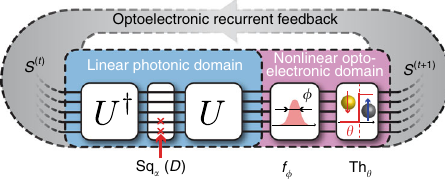
Fig. 1 Operation principle of the PRIS. A photonic analog signal, encoding the current spin state S ( t ) , goes through transformations in linear photonic and nonlinear optoelectronic domains. The result of this transformation S ( t + 1) is recurrently fed back to the input of this passive photonic